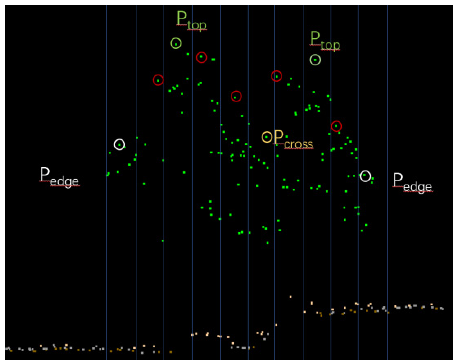
Figure 8. The subsegment of the profile, and the positions of P edge and P cross